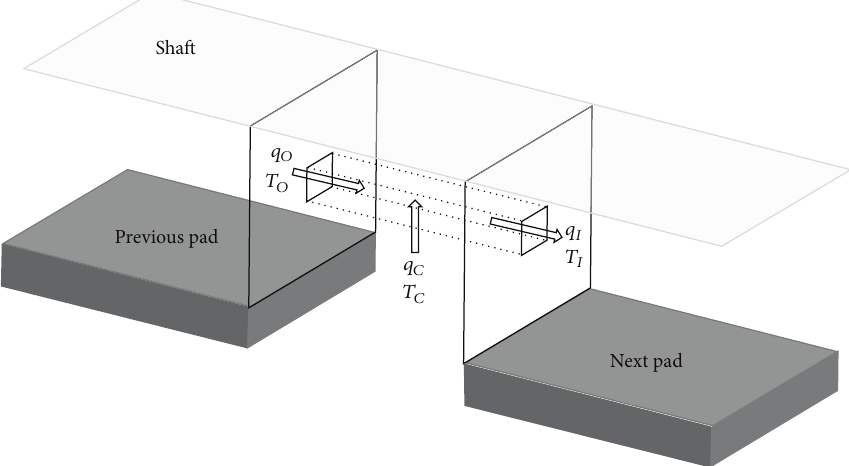
Figure 2: Energy balance in the mixing region between the pads, highlighting one of the control volumes of this region.